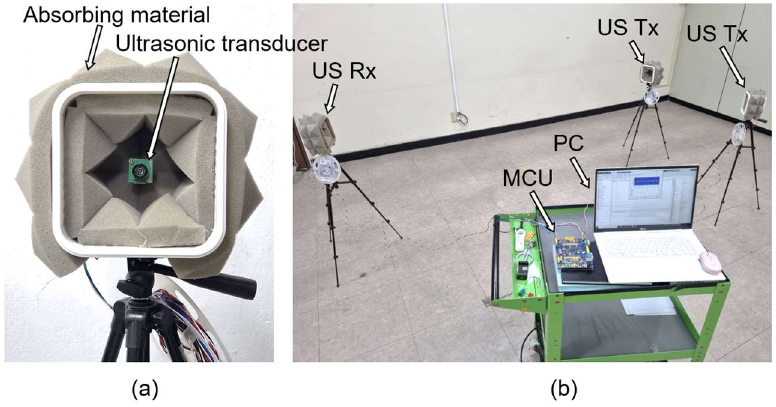
Figure 5. Ultrasonic transceiver system block diagram for proposed algorithm verification.